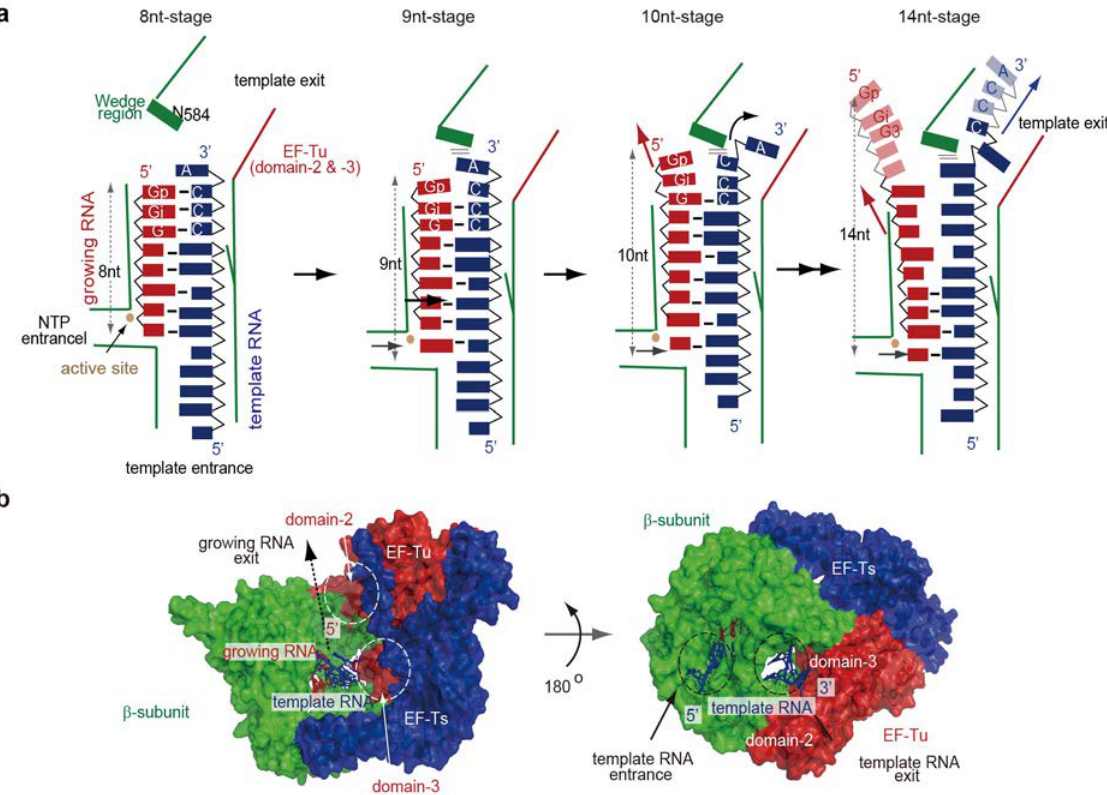
Figure 5. Elongation stages of RNA polymerization. ( a ) Simplified depiction of the structures representing the elongation stages of RNA polymerization by Qβ replicase; ( b ) Template tunnels in the core Qβ replicase. Surface model of the elongation stage, where a fourteen nucleotide-long RNA is synthesized (14nt-stage in Figure 4). The β-subunit, EF-Tu and EF-Ts are colored green, red and blue, respectively. The template and growing RNAs are depicted by blue and red stick models,